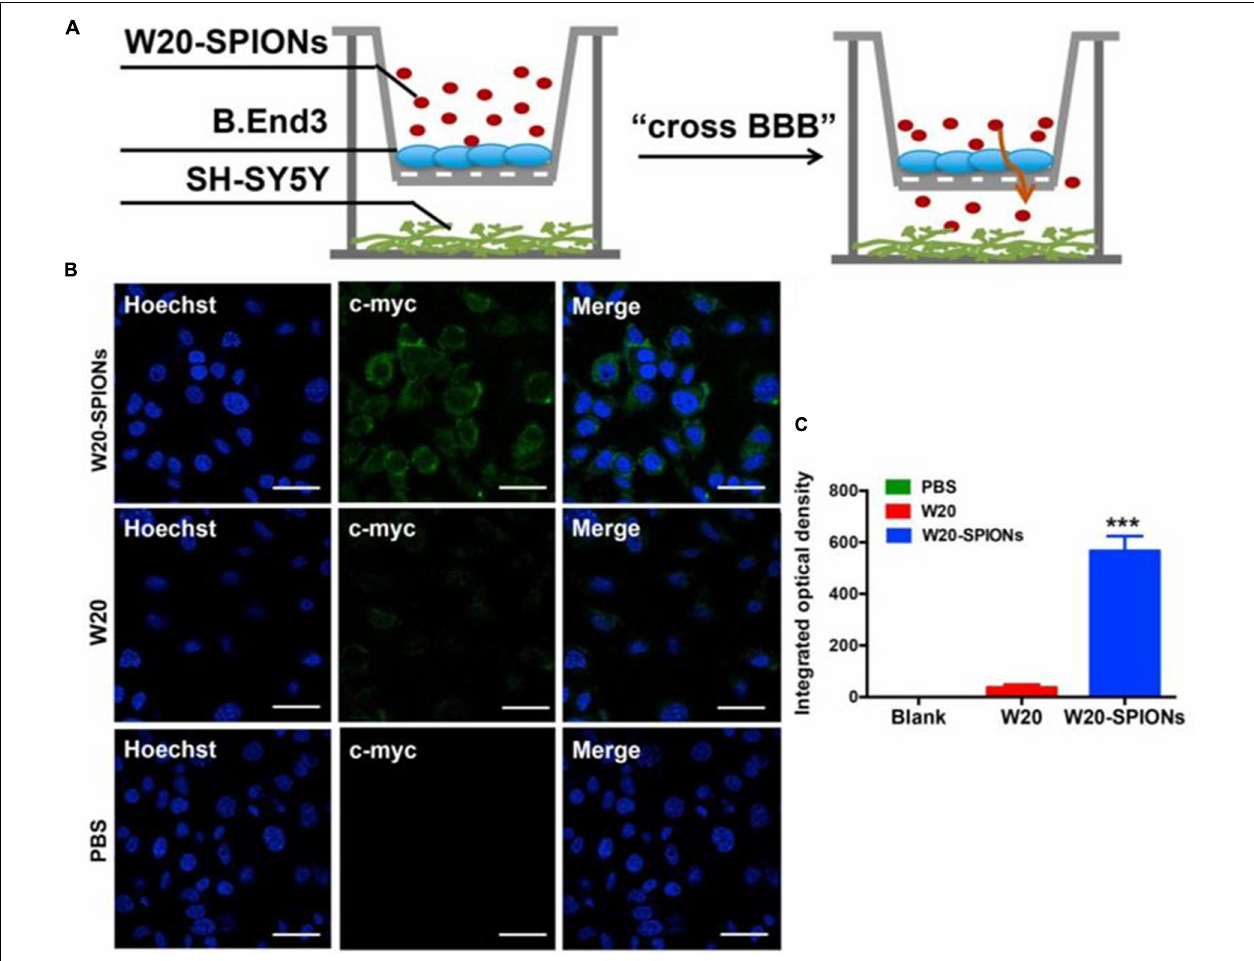
FIGURE 5 | (A) The schematic illustration of in vitro BBB transwell system. (B) b. End 3 cells were incubated with W20-SPIONs, W20 or PBS, and their uptake in SH-SY5Y cells was detected by anti-c-myc antibody and subsequently with secondary antibody conjugated to Alexa Fluor 488. Scale bars, 20 µ m. (C) Quantitative immunofluorescence analysis of W20 signal in SH-SY5Y cells. Reprinted from Liu et al. (2018), with permission from Elsevier. *** p <